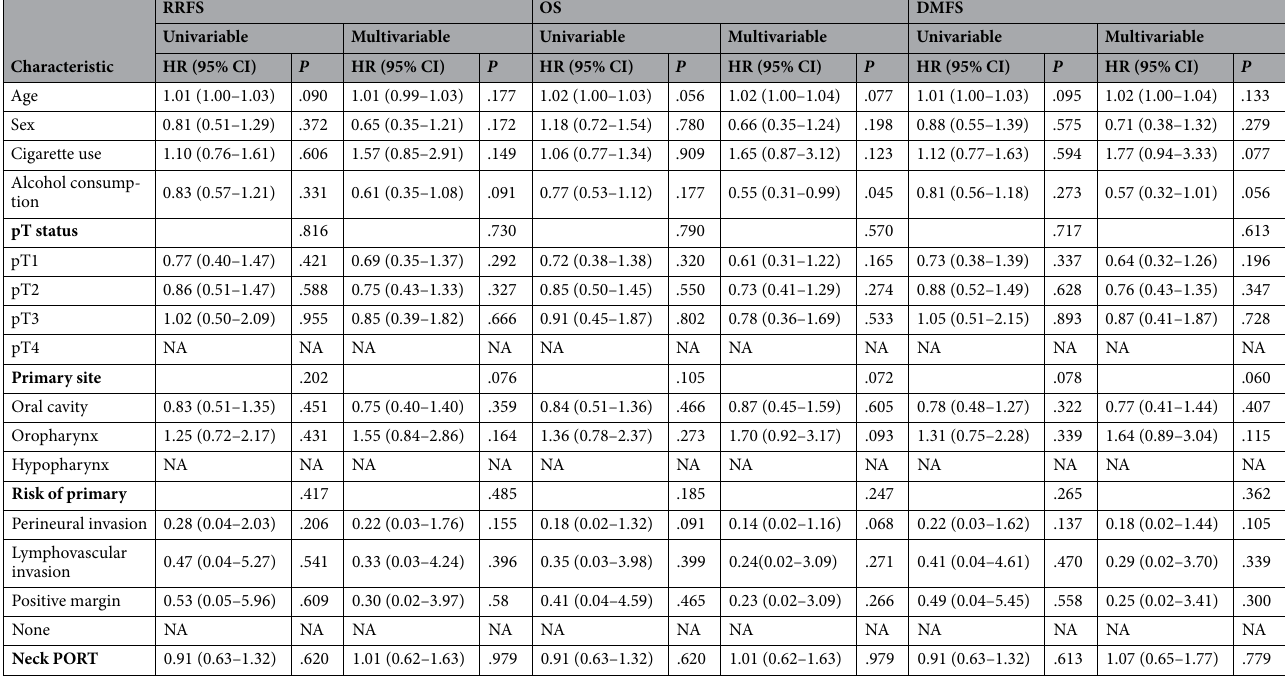
Table 5. Cox proportional hazards regression analysis of survival in 114 matched patients. RRFS regional recurrence-free survival, OS overall survival, DMFS distant metastasis-free survival, pT status pathologic tumor status, HR hazard ratio, CI confidence interval, NA not